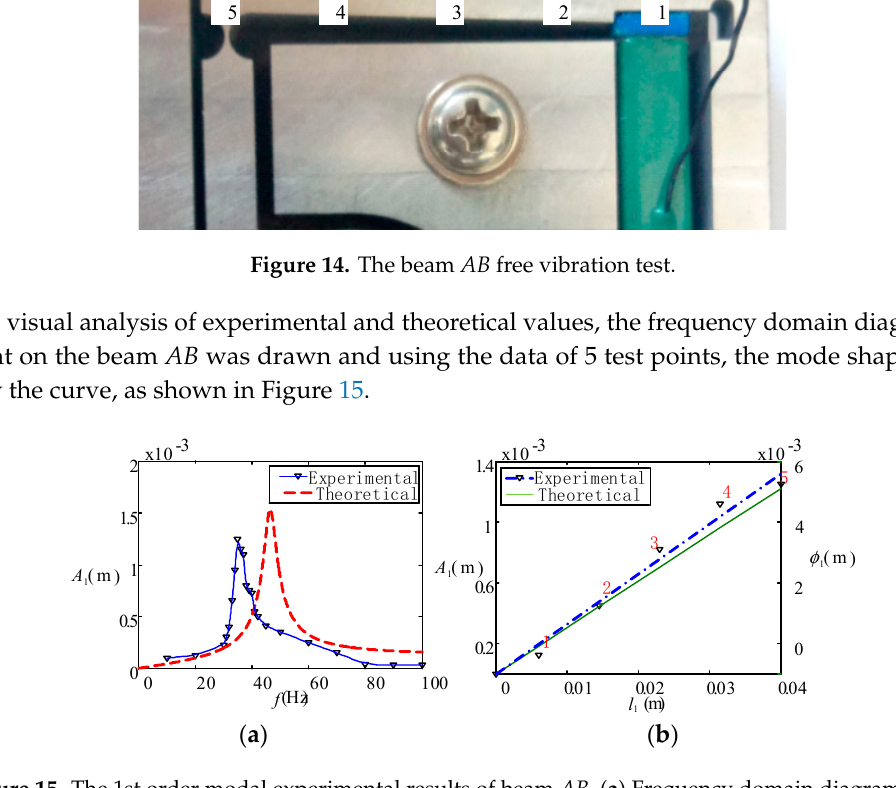
the 5th point on the beam AB ; ( b ) mode shape. 5th point on the beam AB ; ( b ) mode